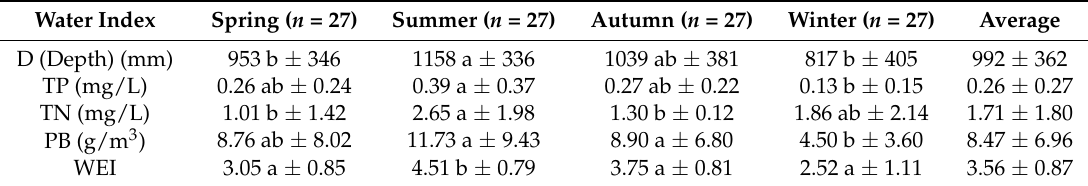
Table 4. Seasonal variation in water quality and the WEI in the Xianlin sub-city (average ± SD).